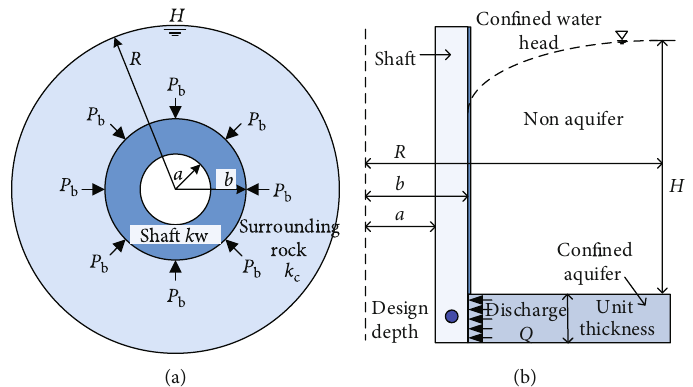
Figure 1: Vertical shaft-surrounding rock seepage model: (a) illustration of shaft geometry parameters; (b) assumed seepage